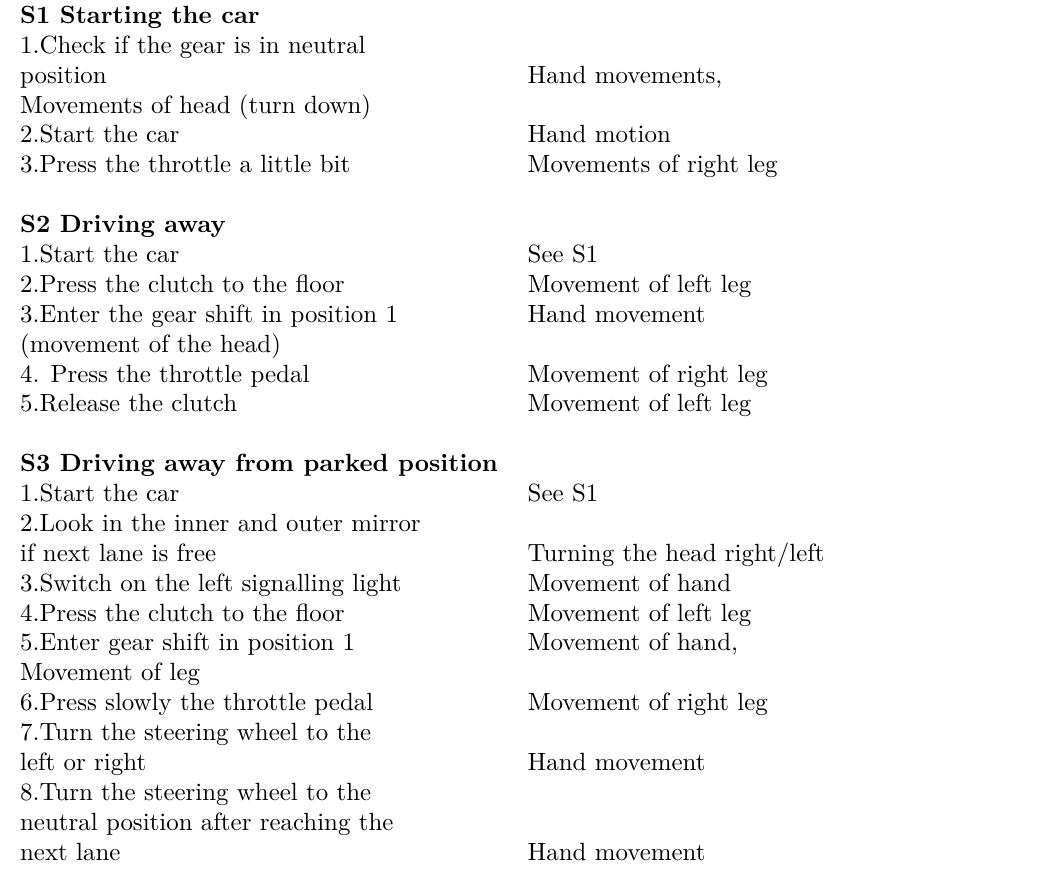
Table 4. Scenarios and behavioural cues.